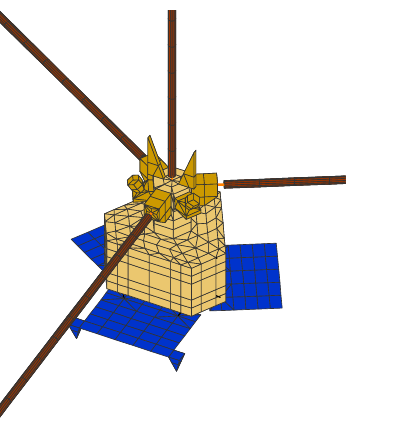
Figure 3. Final, detailed patch-grid model of the RESONANCE spacecraft, oblique view.